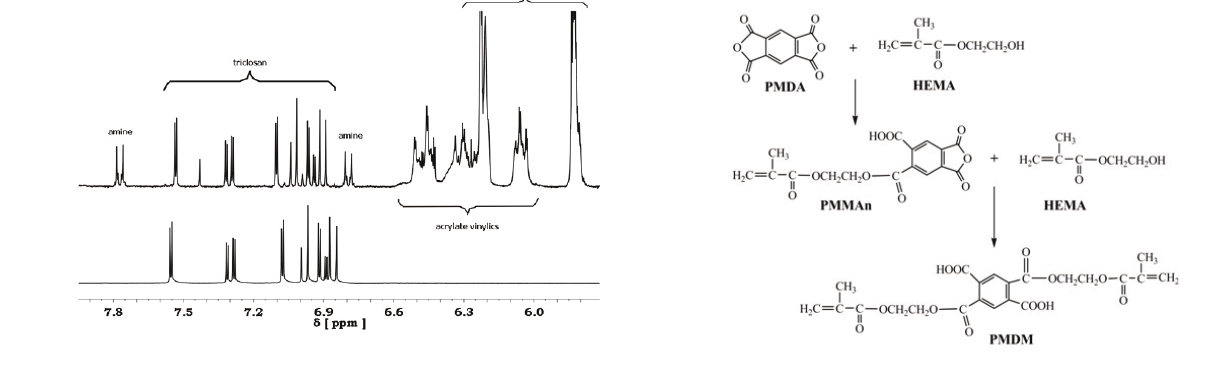
Figure 3: 1H NMR spectra of Seal&Protect (upper) and triclosan (lower run); aromatics and vinylics absorption range. Table 3: NMR based quantitative data on Seal&Protect composition (organics only)